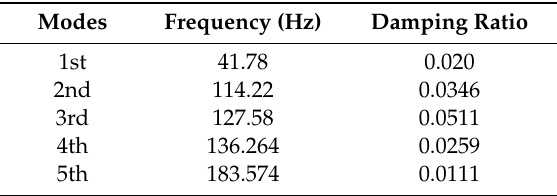
Figure 5. Experimental modal analysis of the set-up with the steel disk. The fitted modal model was obtained using five poles, for which the frequencies and damping ratios are reported in Table 2. Table 2. Eigenfrequencies and damping ratio values of the fitted modal model for the set-up with the steel disk